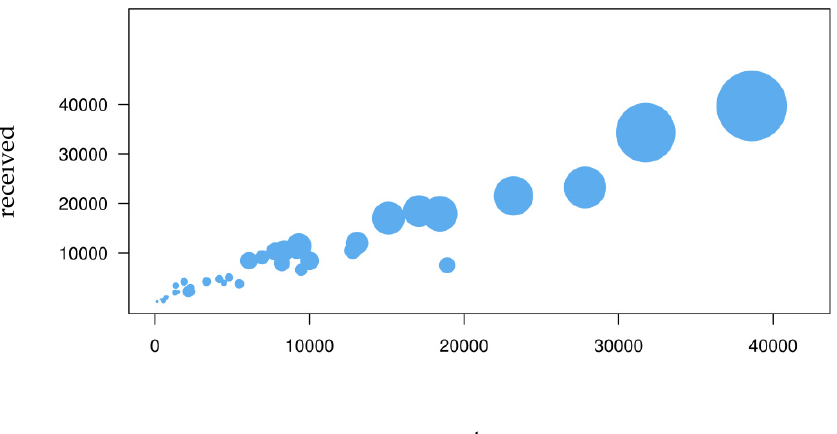
Figure 1. Total number of emails sent and received by each department (bubble size equals number of department members). Table 1. Department level statistics (top 10 departments in emails sent).